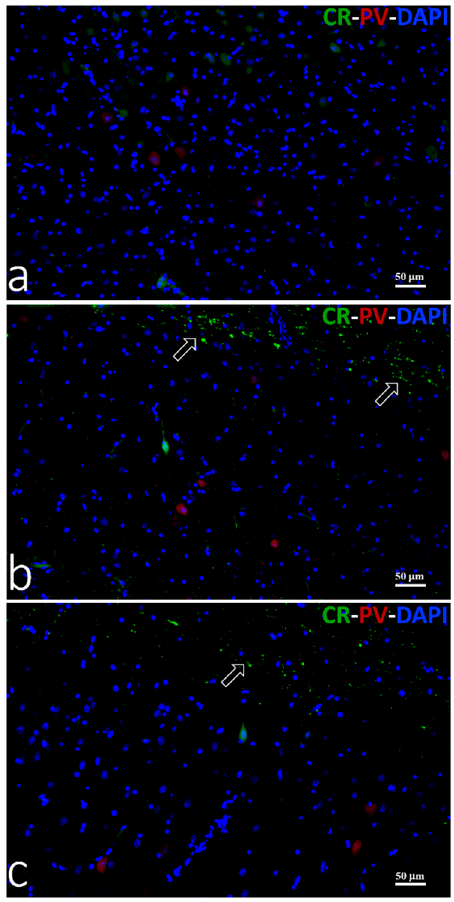
Figure 5. Immunofluorescent staining to PV (red) and CR (green) in M1. Neurons co-expressing PV and CR were not found in the motor cortex of newborn ( a ), young ( b ), or adult ( c ) domestic pig. Arrows ( b , c ) indicate CR positive varicose fibers in layers I/II of M1. Cell nuclei were counterstained with DAPI.